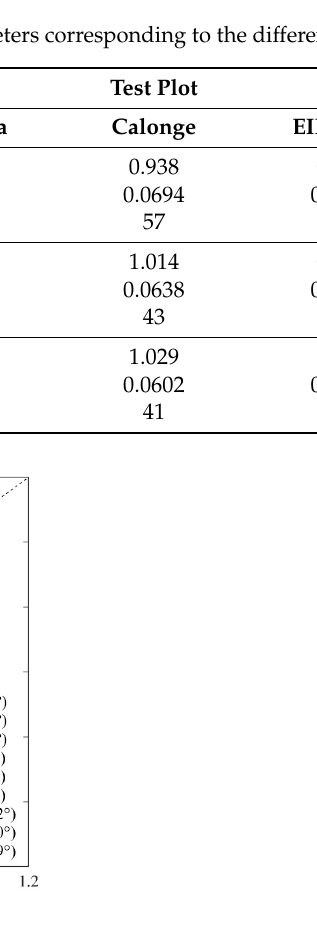
Figure 10. Correlation plots of the rice height estimations with respect to the ground-truth data. The height evolutions for Minima (triangles), Calonge (diamonds), and EIReboso (squares) with 22° (green), 30° (blue), and 39° (orange) incidence angles are plotted. Table 5. Statistics of the correlation between the field measurements and height estimates obtained with the time-series RVoG model based on the logistic growth equation.